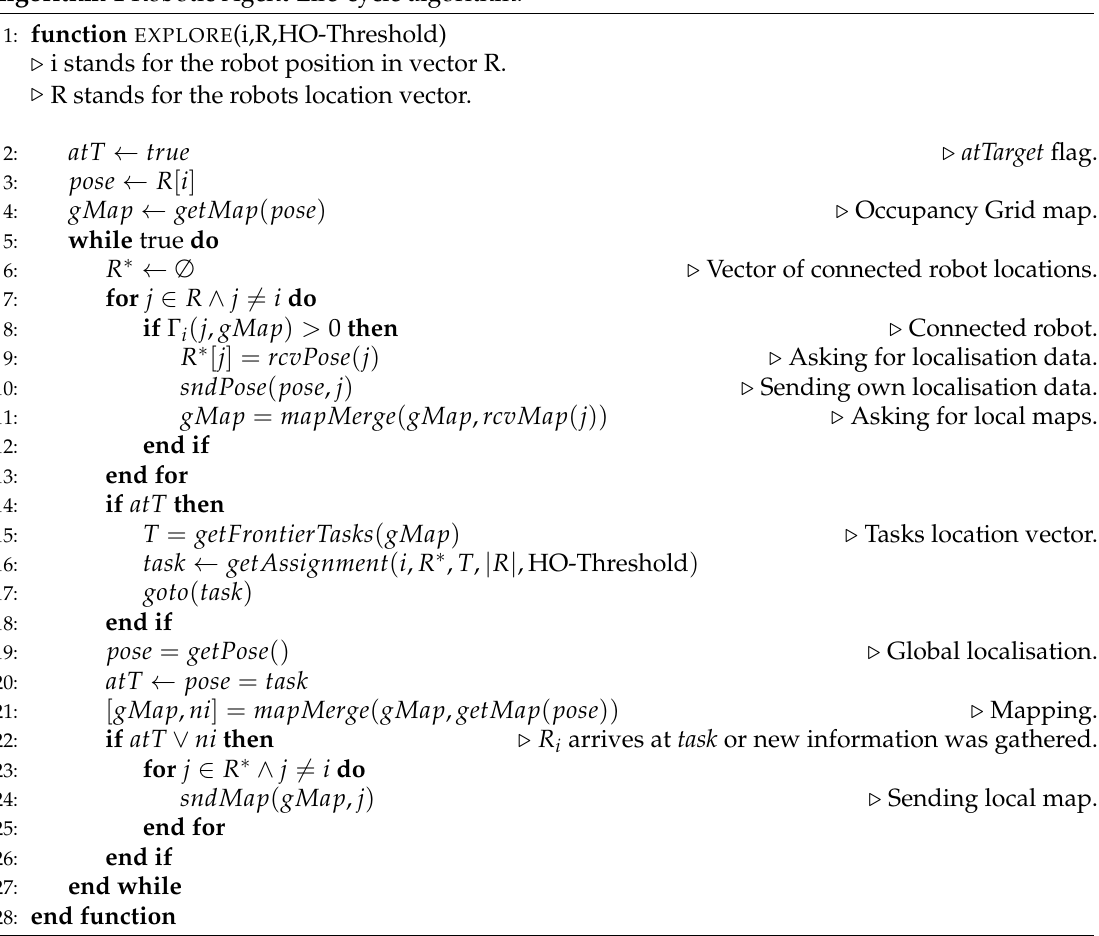
Algorithm 1 Robotic Agent Life-cycle